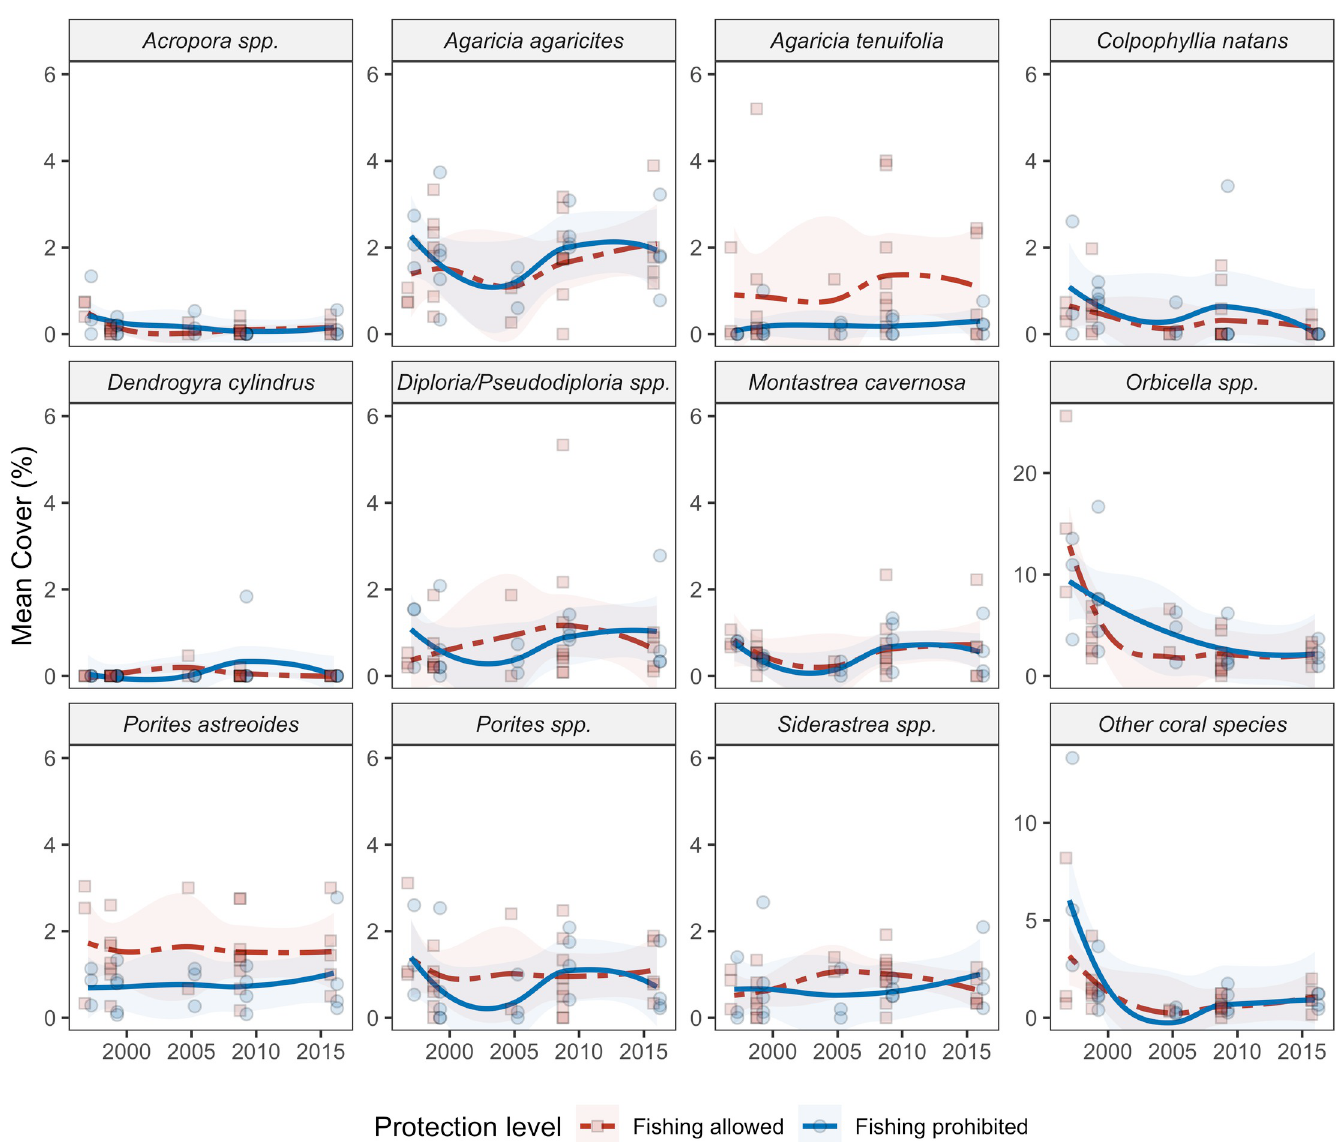
Fig 5. Mean percent cover of twelve taxonomic categories of hard corals, grouped by protection status. Fishing occurs at sites coded red and is prohibited at sites coded blue. Points are site means for each surveyed year, lines are a loess smoothed curves with a span of 1, and shading indicates the 95% confidence intervals of the loess